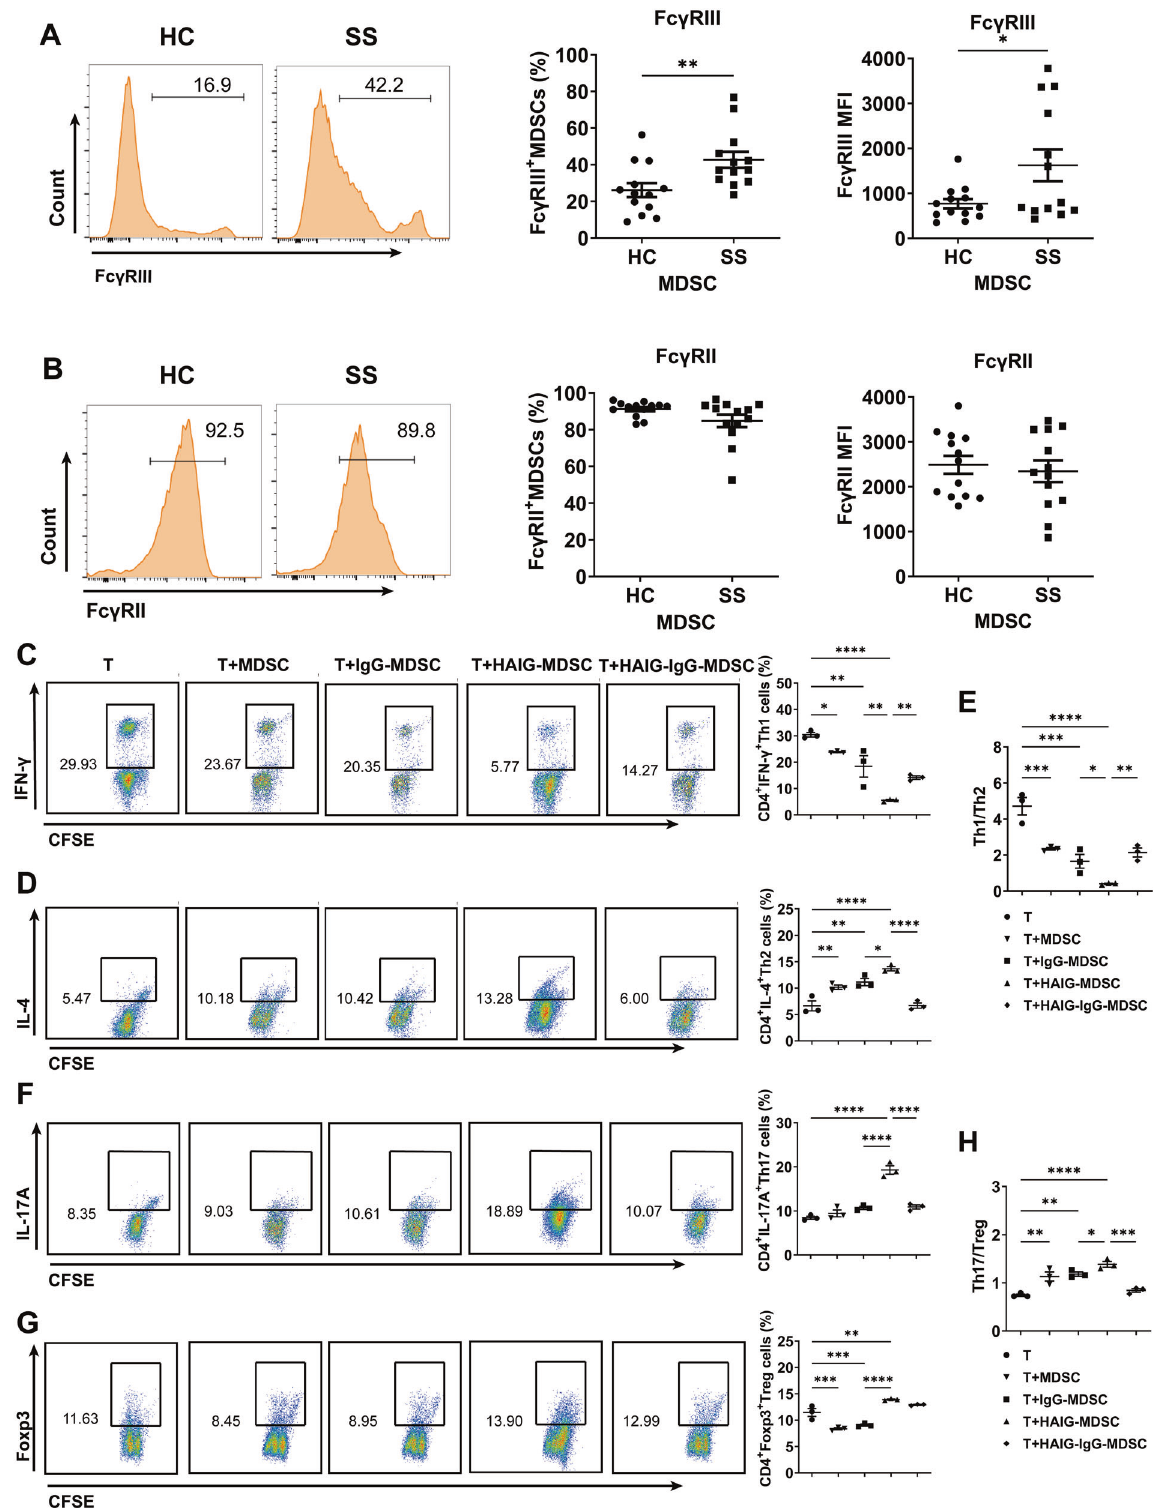
Fig. 3 Fc γ RIIIA activated MDSCs disturbed the balances of Th1/Th2 and Th17/Treg cell subsets. A , B Fc γ RIII and Fc γ RII on peripheral MDSCs (HC n = 13, SS n = 13) were detected by fl ow cytometry. Representative fl ow cytometric analysis and percentages of Fc γ RIII + MDSCs and Fc γ RII + MDSCs and the MFI of Fc γ RIII and Fc γ RII on MDSCs from HC and SS patients were shown. C – H MDSCs or IgG-preprocessed MDSCs were stimulated with or without IgG or HAIG for 24 h and then co-cultured with CFSE-labeled CD4 + T cells for 72 h. Representative fl ow cytometric analysis and percentages of CD4 + T cell subsets were shown. C CD4 + IFN- γ + Th1 cells, D CD4 + IL-4 + Th2 cells, E the ratio of Th1/Th2, F CD4 + IL-17A + Th17 cells, G CD4 + Foxp3 + Treg cells, H the ratio of Th17/Treg. All the data are representative of two independent experiments. n = 4, * p < 0.05, ** p < 0.01, *** p < 0.001, **** p < 0.0001. Cell Death and Disease (2023)